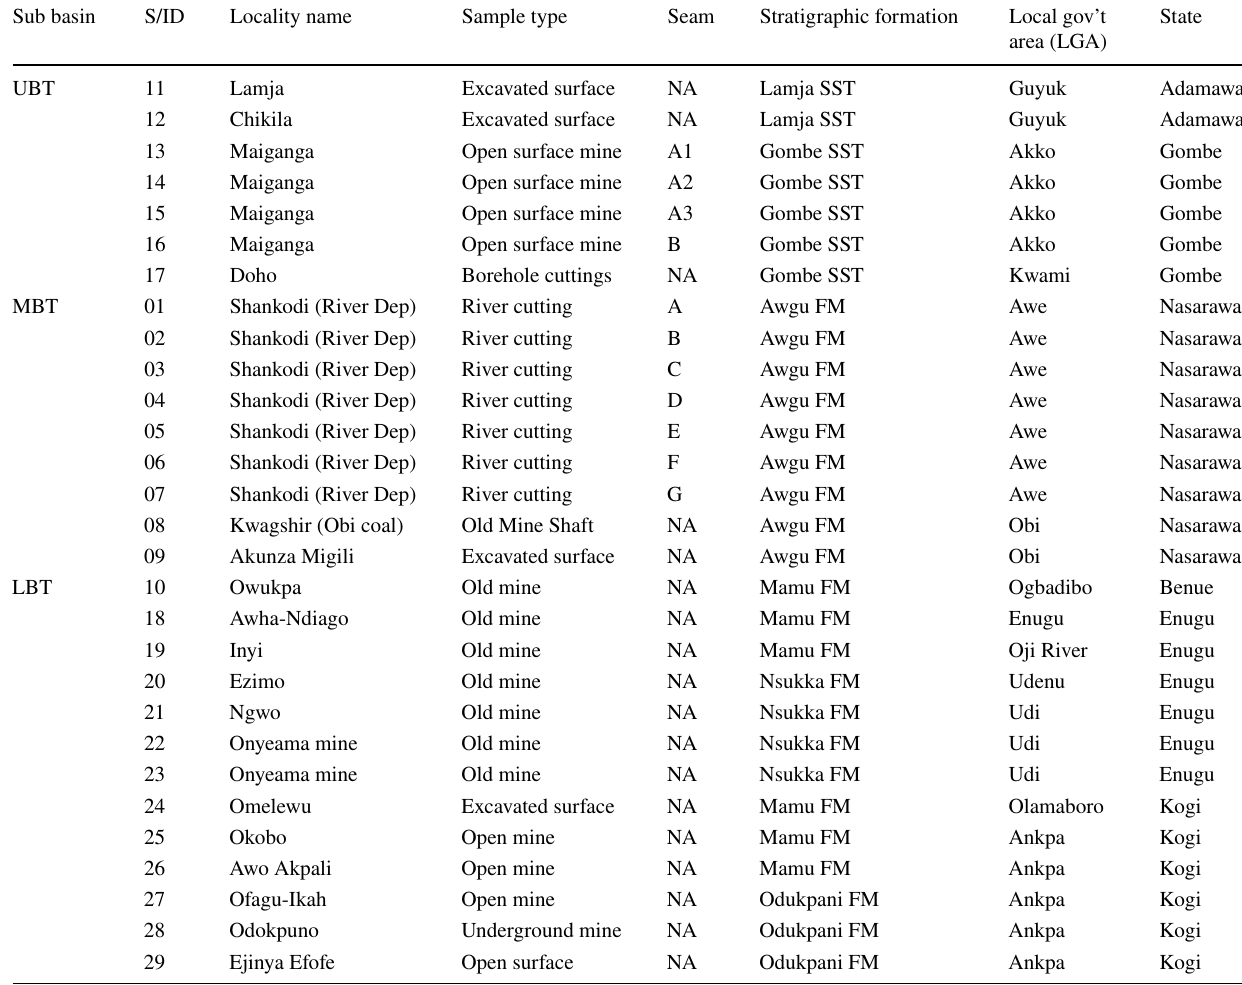
Table 2 Sample localities and identification (S/ID = Sample Identification; NA = Not ascertained due to lack of information) Sub